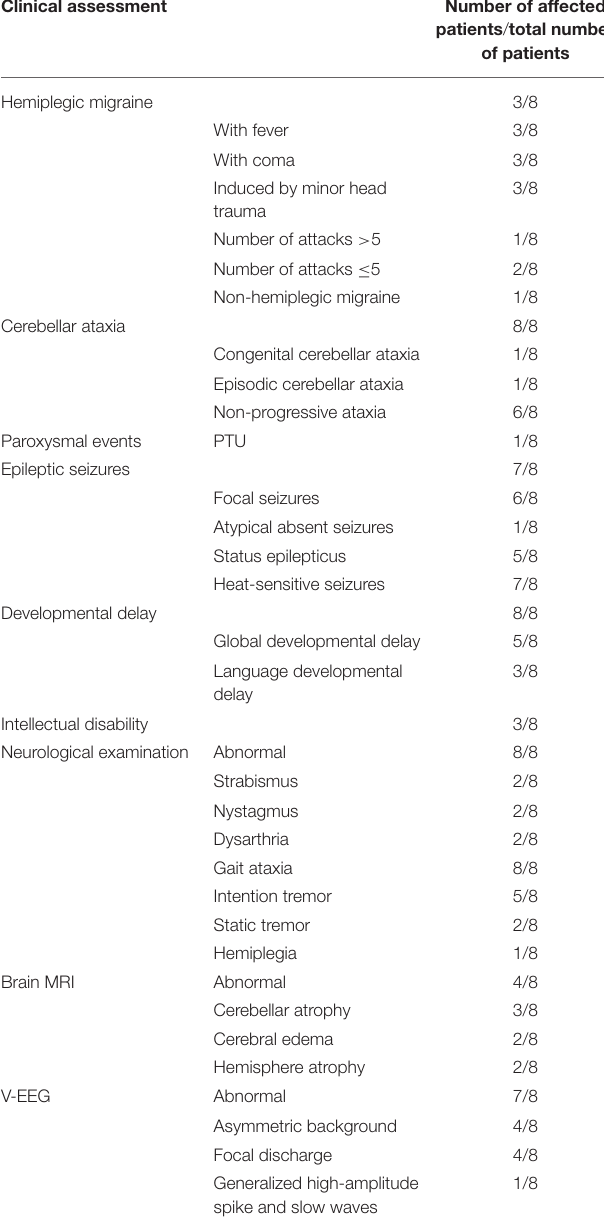
TABLE 2 | Clinical features of the eight patients with CACNA1A